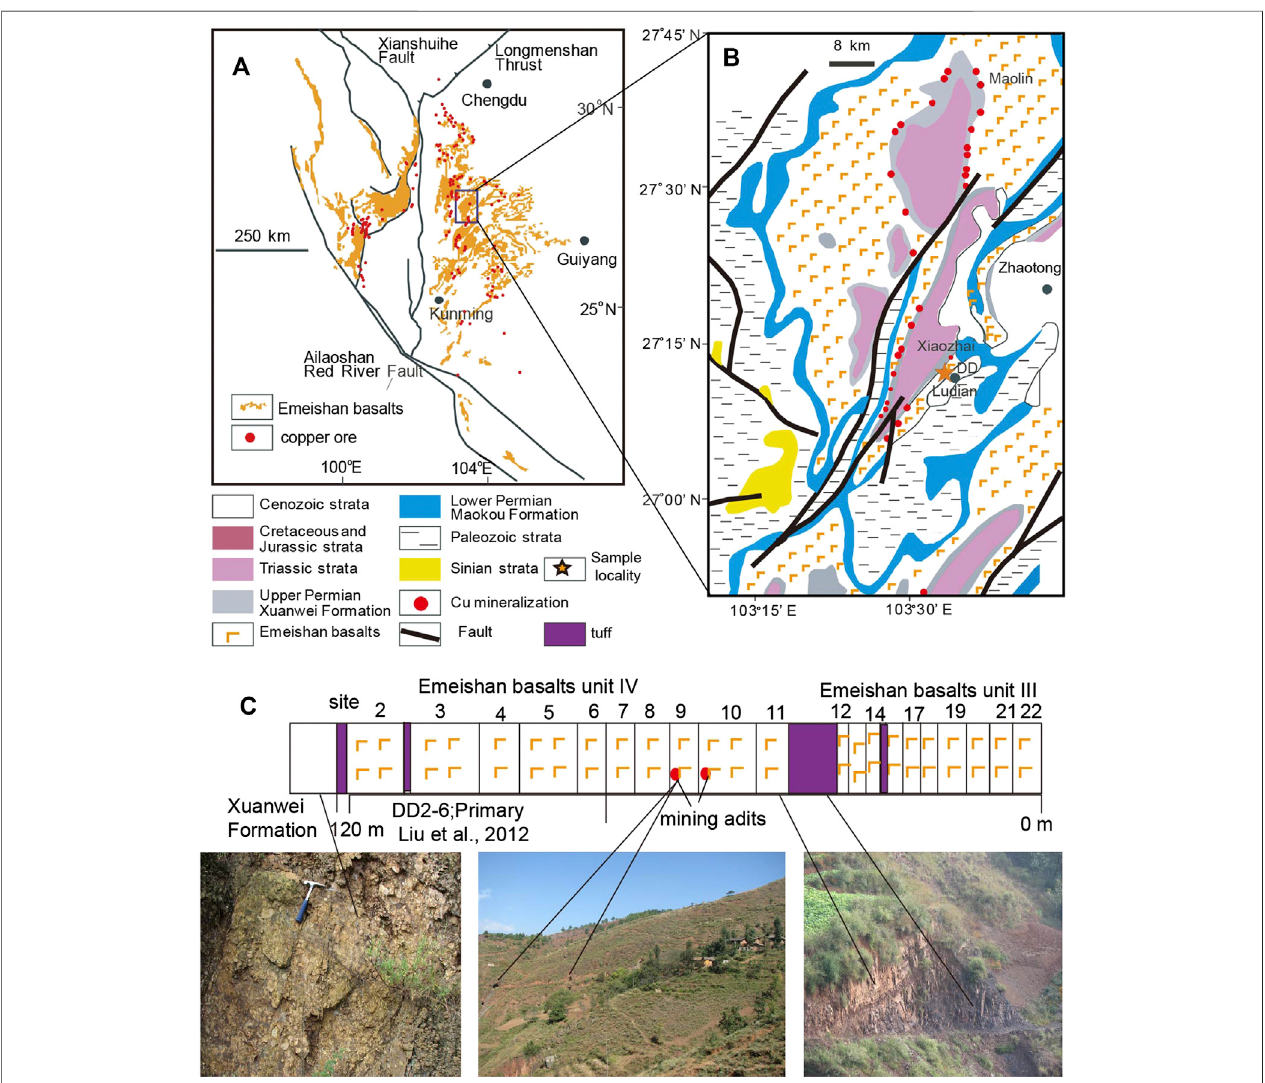
FIGURE 1 | (A) The distribution of the Emeishan basalts and cooper ore in southwest China (after Li et al., 2009) (B) Geologic map of the Zhaotong area, Yunnan Province, showing the distribution of copper mineralization localities (after Wang et al., 2006) and the sample locality (DD) (C) The lithology column of Dadi section and typical outcrop